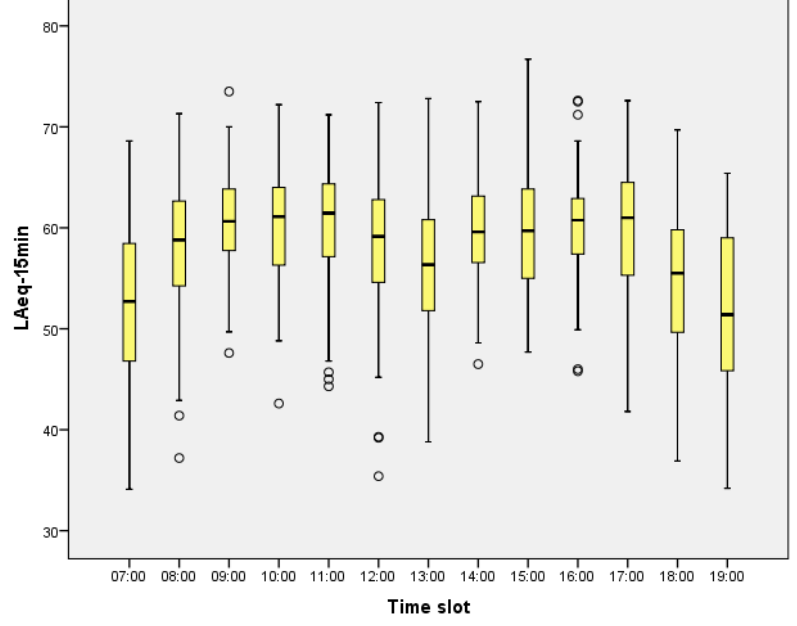
Figure 10. Distributions of L Aeq-15min scores as a function of the time slot.